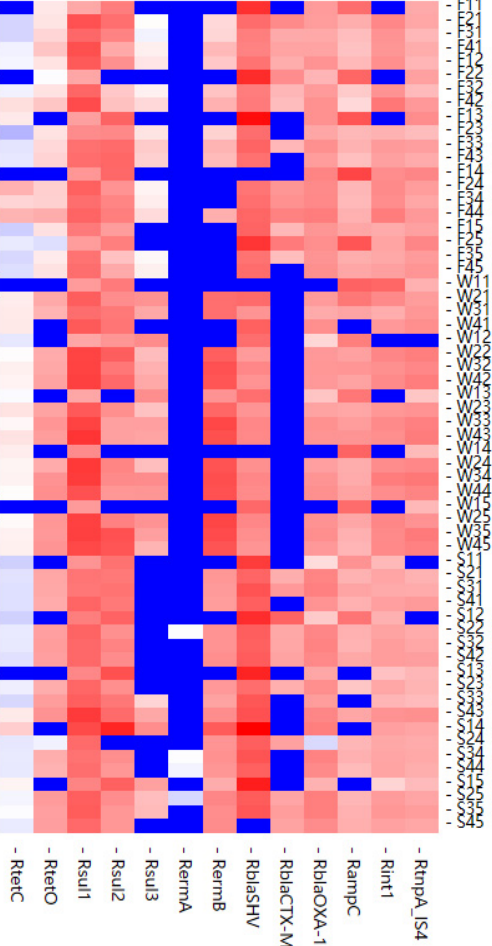
Figure 4. Heatmap showing relative abundance of ARGs in all samples.